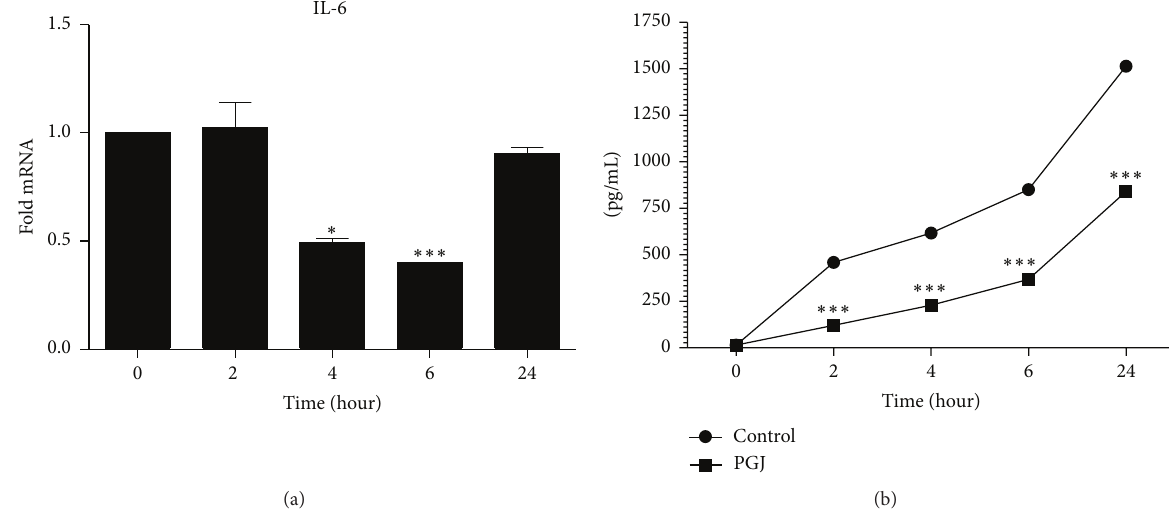
Figure 4: Decreased relative IL-6 mRNA expression and release, TPC-1cells treated with 15d-PGJ 2 . TPC-1cells were treated with 15d-PGJ 2 (9,8 𝜇 M) for 0 to 24 h. (a) shows the relative IL-6 expression. (b) Quantitative IL-6 released by TPC-1cells treated with 15d-PGJ 2 against the control group. The data are presented as means ± standard deviation of three replicates from at least three independent tests. An asterisk ∗ indicates statistically significant difference from the control group ( ∗ 𝑃 > 0.01 ; ∗∗∗ 𝑃 > 0.001